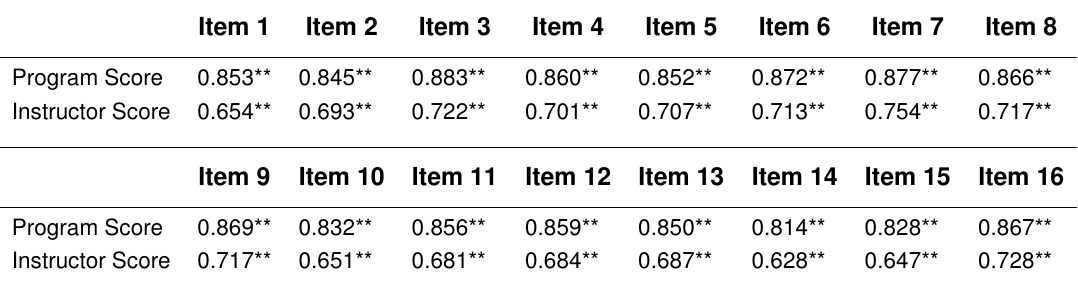
Correlation Coefficients on the Relationships between Perceived Program Characteristics, Perceived Instructor Characteristics, and Perceived Benefits of the Program Item 1 Item 2 Item 3 Item 4 Item 5 Item 6 Item 7 Item